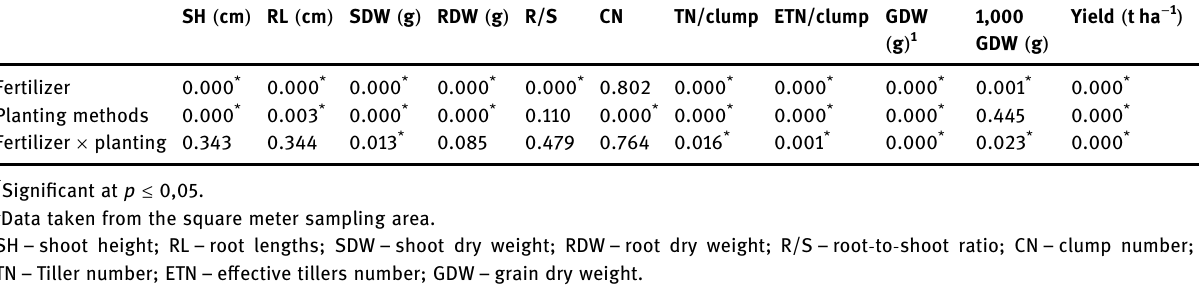
Table 3: The main e ff ect of fertilizer combination and planting method on rice growth parameters measured 60 days after planting Treatments Fertilizer combination Control ( C )